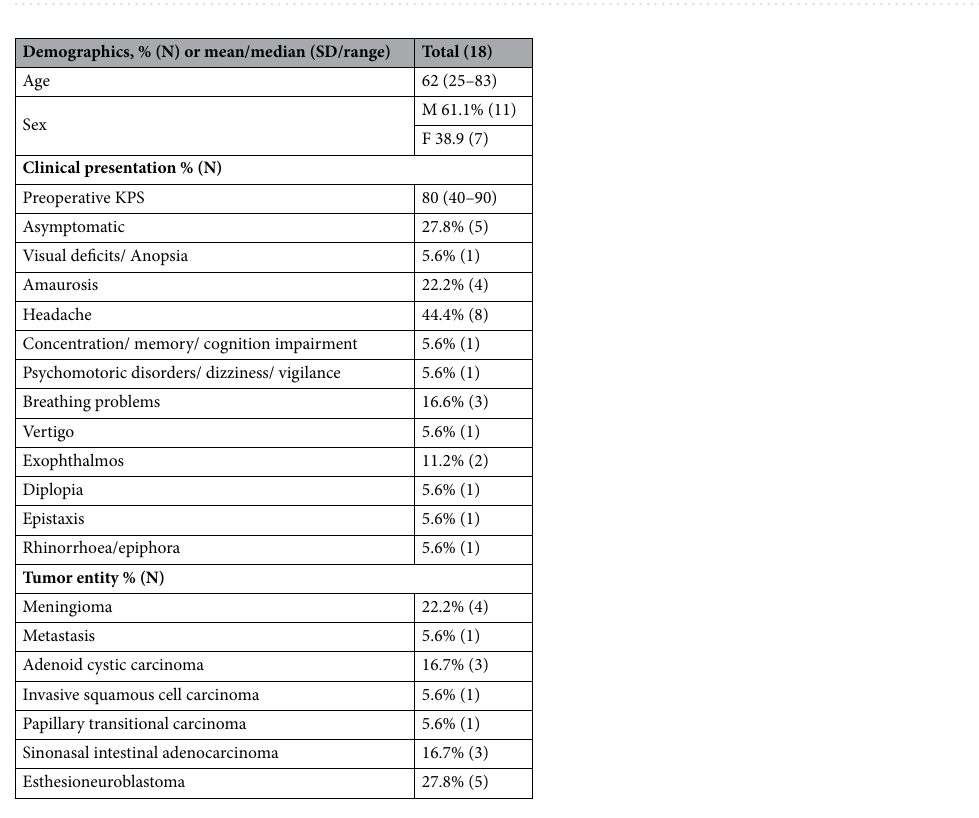
Figure 1. Exemplary case 1: a 74-year-old female patient admitted after fall at home and back pain. Cranial routine CT scan displayed a huge transbasal bone infiltrating and destroying a tumor with sinonasal affection. ( A , B ) Preoperative T1-weighted gadolinium-enhanced MR imaging showing sinonasal and orbit-infiltrating tumor with subtotal anterior skull base destruction. ( C , D ) Postoperative MR control showing successful resection. Reconstruction was performed with split-bone graft and galea-periosteum flap. Pathologic findings revealed adenoid cystic carcinoma. The patient recovered well from the procedure; she underwent VP-shunt implantation in further course.